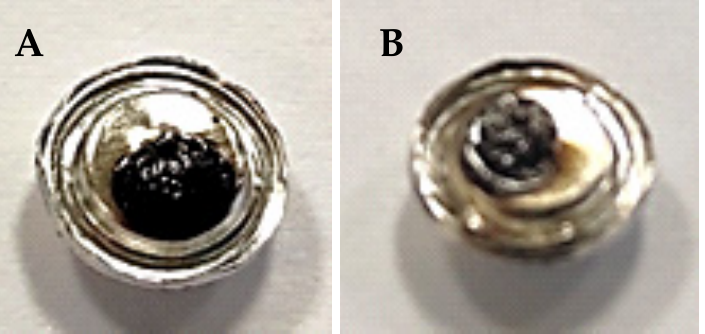
Figure 14. DSC 25-µL measurement vessels with a lid with a hole of 0.3 mm in diameter. Vessels after experiments (see Figure 13). Weight of each of the samples was ~5 mg ( A and B have the same meaning as in Figure